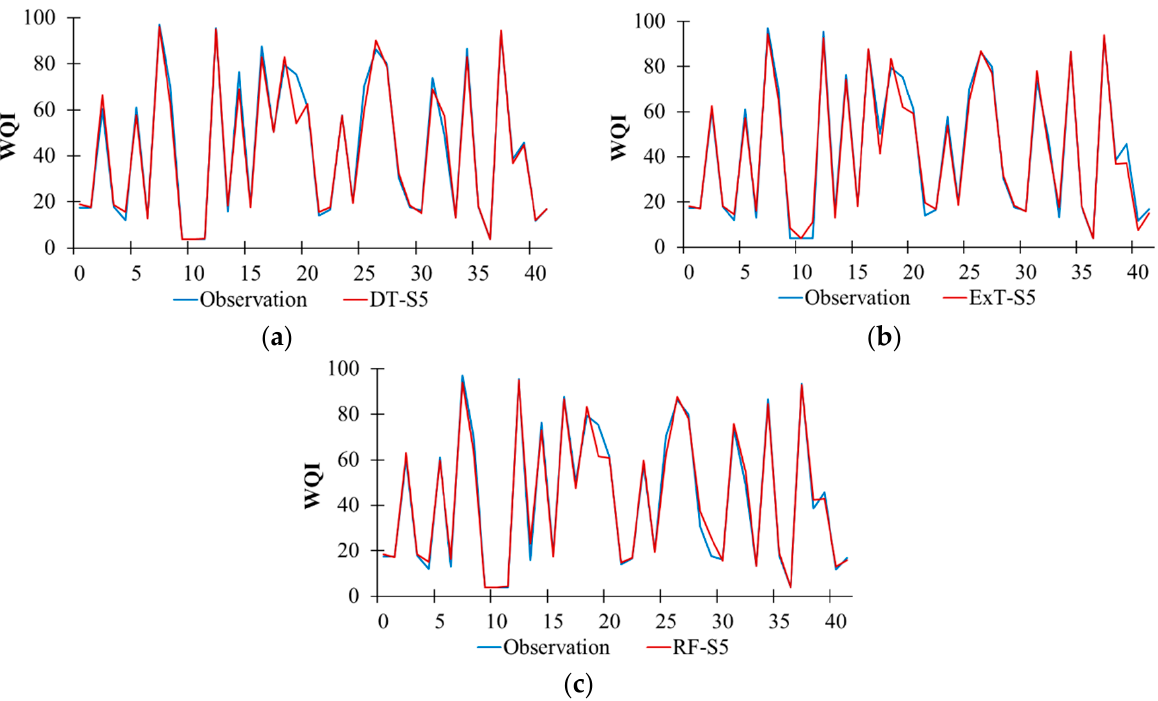
Figure 3. Temporal variation in the observed and predicted WQI values for the best performance models using decision tree-based algorithms during the testing period. ( a ) DT-S5. ( b ) ExT-S5. ( c ) RF- S5.